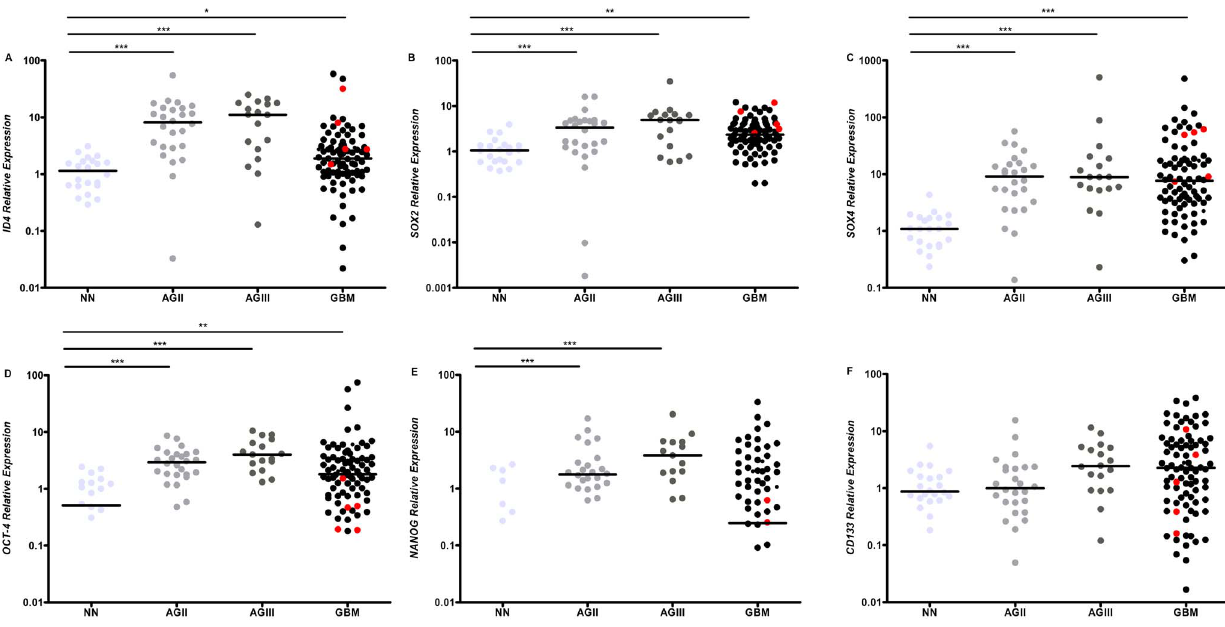
Figure 1. Expression levels of genes in diffusely infiltrative astrocytomas (AGII to GBM). Transcript levels of ID4 (A), SOX2 (B), SOX4 (C), OCT-4 (D), NANOG (E) and CD133 (F) were determined in 26 low-grade astrocytomas (AGII), 18 anaplastic astrocytomas (AGIII) and 86 GBM cases relative to 22 non-neoplastic (NN) by quantitative real-time PCR. Relative expression values were calculated based on the geometric mean of HPRT , GUSB and TBP expression levels of each sample and non-neoplastic brain values. The following equations were applied to calculate gene relative expression according to primer efficiency (E) in tumor samples versus the mean of non-neoplastic tissues: 2 2 DD Ct [27] for SOX2 , SOX4 , OCT-4 and CD133 ; and 1 + E 2 DD Ct [28] for ID4 and NANOG , where D Ct=Ct specific gene – mean Ct of housekeeping genes and DD Ct= D Ct tumor – mean D Ct non-neoplastic. Red dots represent the secondary GBM cases. Horizontal bars show the median of each group and the values are presented in Table 2. NANOG expression in 15 NN and 40 GBM cases was very low and, as a result, the horizontal bar for NN does not appear in the graphic (median=0). The difference of relative gene expressions among the groups were statistically significant ( p , 0.0005 for ID4 , SOX2 , SOX4 , OCT-4 and NANOG ; and p , 0.05 for CD133, Kruskal-Wallis test). A pair-based comparison was assessed using Dunn test. The p value results are shown, where *** p , 0.0005, ** p , 0.005 and * p , 0.05.